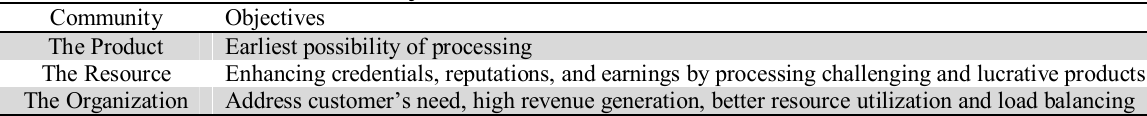
Different communities and their objectives